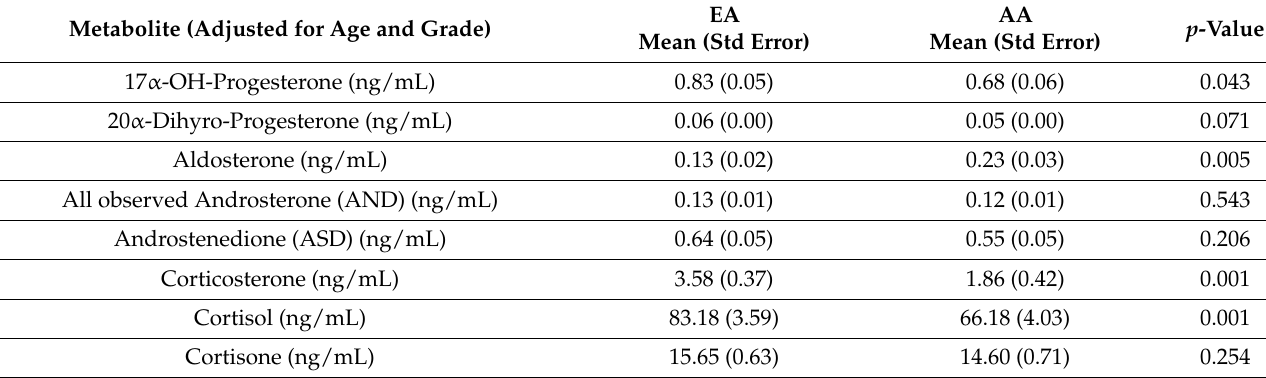
Figure 2. Serum metabolite levels are associated with clinical cofactors. The metabolite levels within groups of clinical cofactors were compared using a left-censored version of the log-rank test. * p < 0.05, ** p < 0.01 upon comparisons of the mean values in each category. Each dot represents a single clinical serum sample. ( A ) The mean androstenedione (ASD), dehydroepiandrosterone (DHEA), and hydroxypregnonolone serum levels are significantly higher in men <55 years than in men >=55